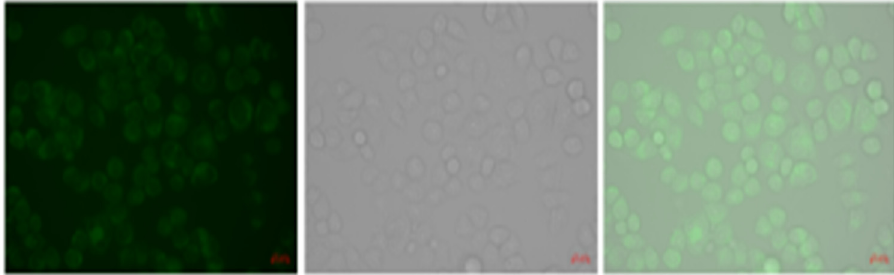
Figure 9: Cell fl uorescence imaging of the